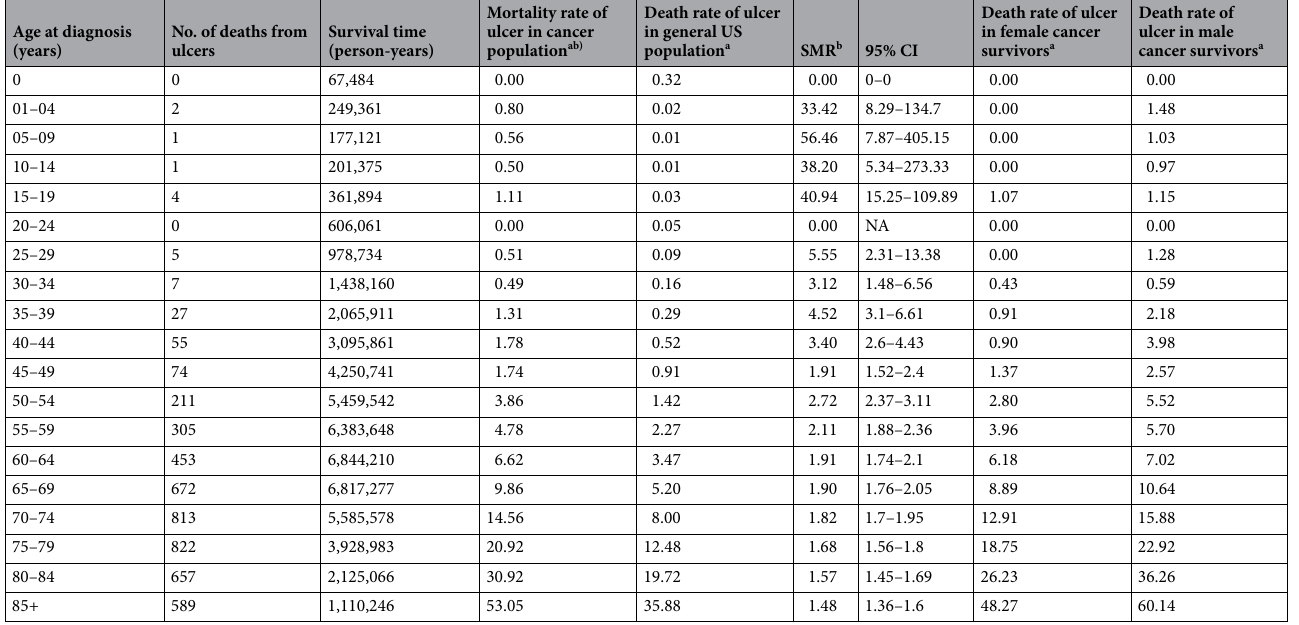
Table 2. Mortality rates of fatal gastroduodenal ulcer in persons with cancer by age at diagnosis. a Per 100,000 person-years. b Reference population: general US population, 1969 to